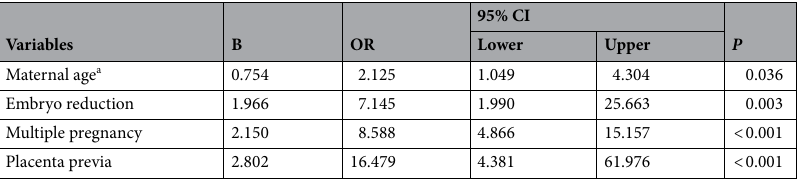
Table 5. Stepwise multivariate logistic regression analysis comparing mothers with early preterm birth and full-term births. Teen factors showing significant differences in the univariate analysis (see also Tables 1, 2, 3) were entered into the stepwise multivariate logistic regression analysis. Full-term birth group was termed as the reference group of dependent variate. The following six factors showed no significant effect on early preterm birth in the stepwise multivariate logistic regression analysis: Apolipoprotein A1, Thrombin time, Treatment cycle, Embryo type, number of embryos transferred, and offspring sex. Reference group was Full-term birth. a Maternal age: 40 or 20–24 vs.